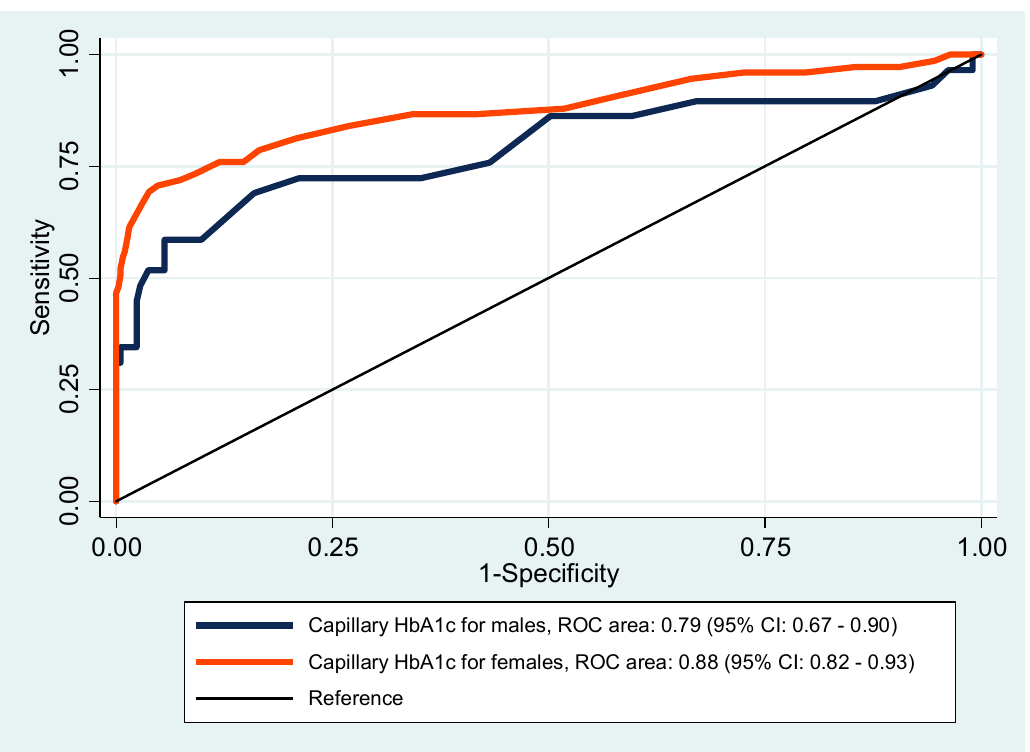
Figure 2. Receiver operating characteristics (ROC) curves for HbA1c to diagnose diabetes by gender.